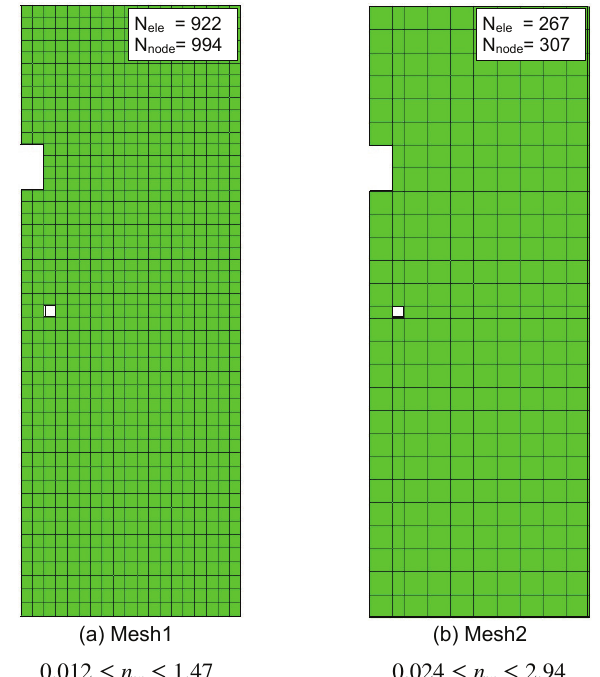
Figure 3. PUFEM mesh with two spatial resolutions: ( a ) Mesh 1 and ( b ) Mesh 2. The range of n w is also shown for